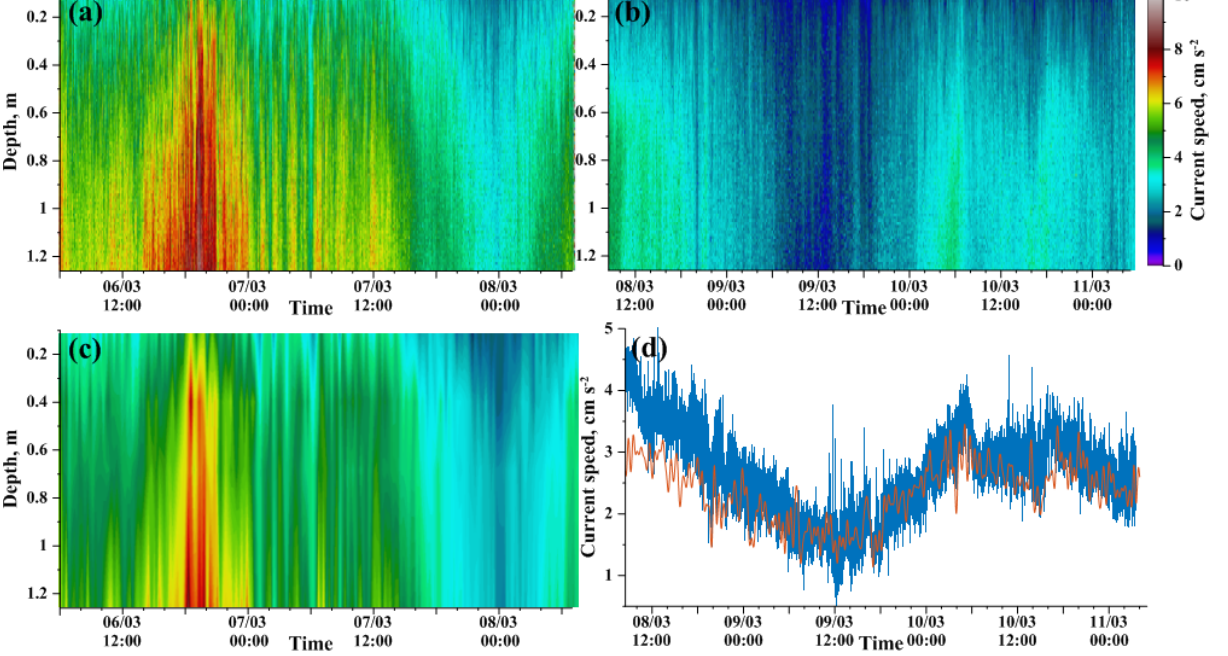
10 − 10 m 2 s − 3 . The characteristic scale of convective veloci- ties (Deardorff, 1970) w ∗ = (B R h S ) 1 / 3 ≈ 1 . 3mms − 1 ,